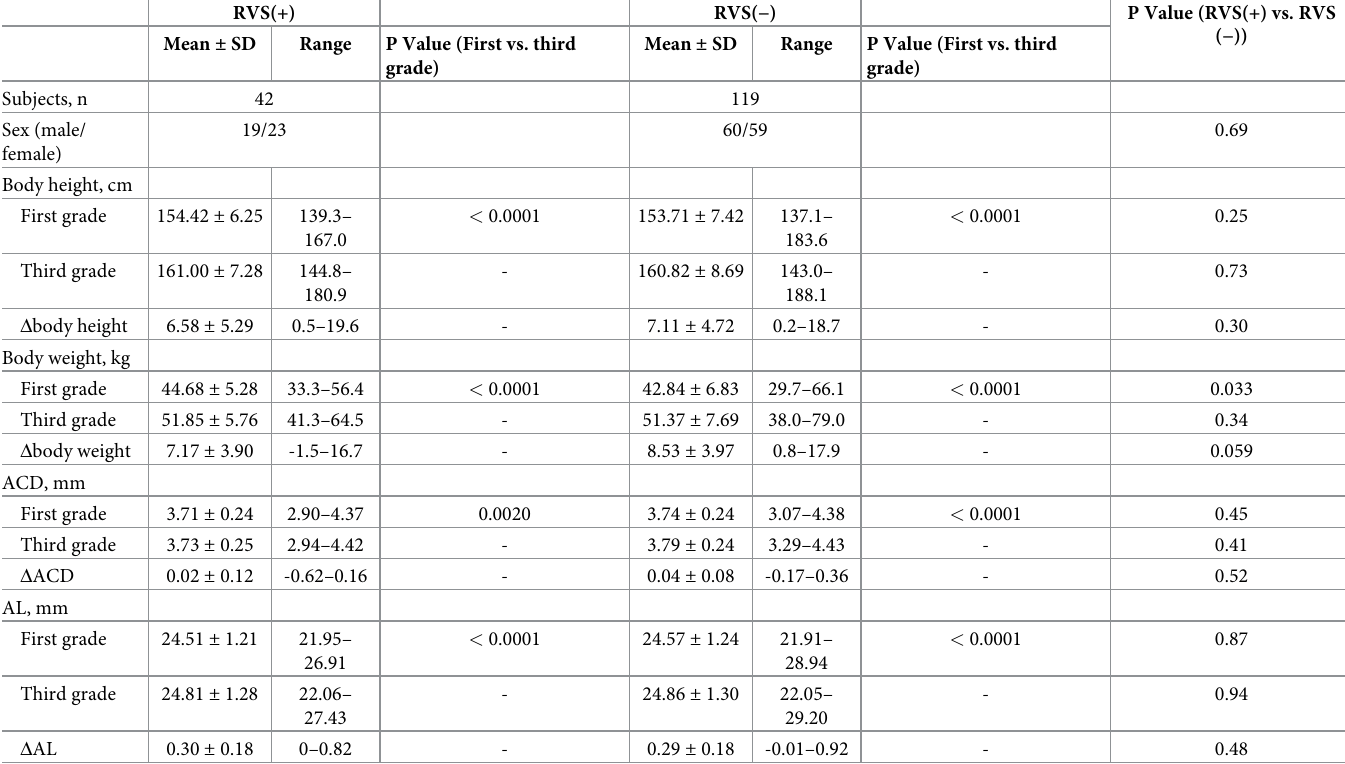
Table 1. Background characteristics of the participants. RVS(+) RVS( − ) Range P Value (First vs. third